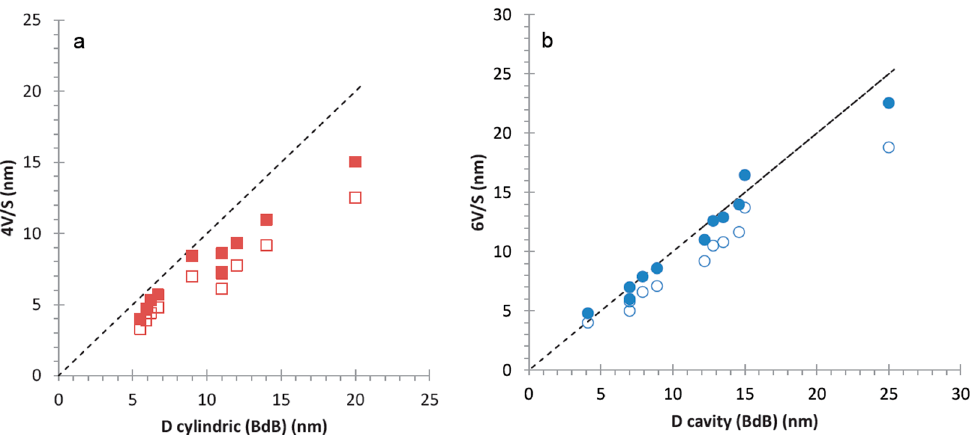
Figure 8. Comparison of mesopore diameters of hierarchical silica monoliths calculated by the geometrical method ( a ) 4 V / S for cylindrical pore hypothesis and ( b ) 6 V / S for spherical pore hypothesis (open square 4 V / S , plain square 4 V / S *, open circle 6 V / S , plain circle 6 V / S *) and mesopore diameters determined by the pressure of capillary condensation with the BdB method as explained in Figure 7.